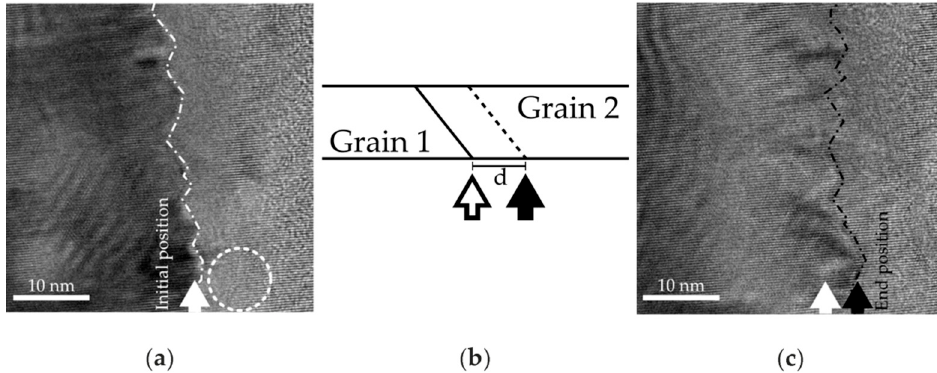
Figure 10. Grain boundary migration in a ZnO film during a flash event in the direction of the applied field. The field of view is near the substrate as shown in Figure 4b; the applied electric field and current are shown in Figure 9. No additional heating was provided to the specimen. The facetted grain boundary moves from its initial position ( a ) (marked by white arrow) a distance of approximately 4 nm in 160 s to the position shown in ( c ) (black arrow). Image ( b ) provides a sketch of the grain boundary structure in ( a ) (solid line) and ( c ) (dashed line). The circled region in ( a ) recrystallizes during the 160